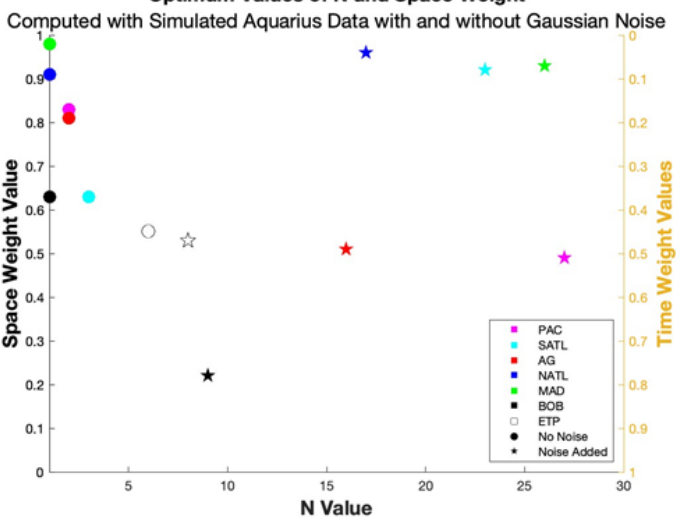
Figure 9. Optimum N and space_weight values found for the simulated Aquarius data set with and without added Gaussian Noise (standard deviation = 0.2, mean = 0).